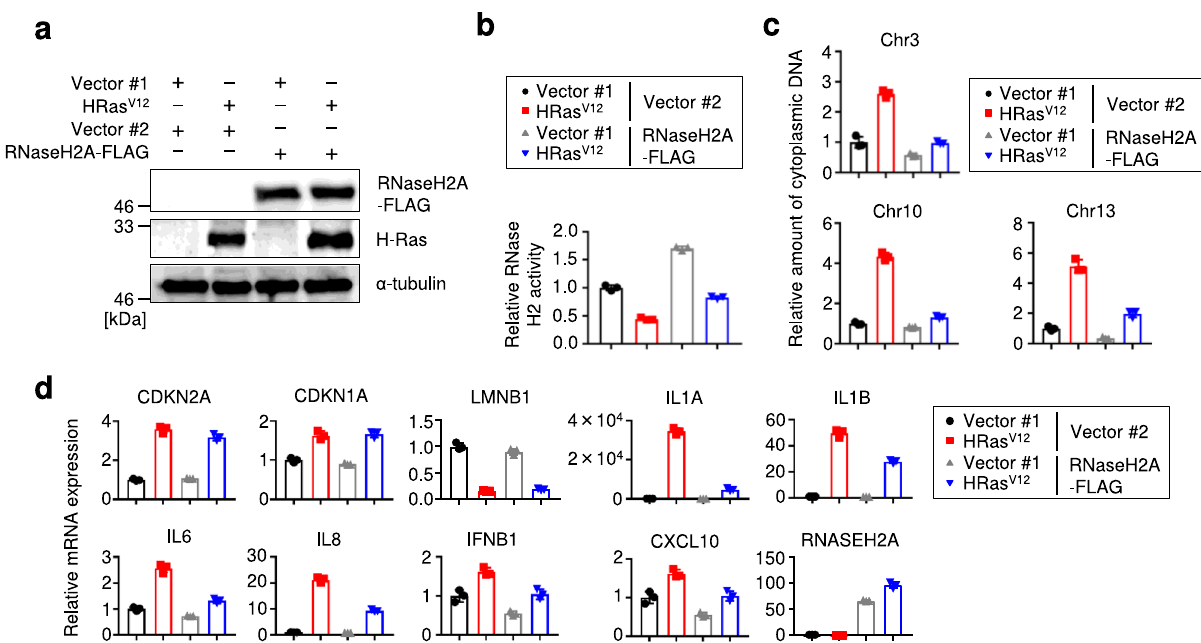
Fig. 5 RNaseH2A suppresses the expression of SASP factor genes. a Western blot of TIG-3 cells infected with retrovirus encoding fl ag-tagged RNaseH2A (lanes 3 and 4) or empty vector (lanes 1 and 2). After puromycin selection, cells were infected with retrovirus encoding HRas V12 and subjected to western blot analysis using the antibodies shown at right. Alpha-tubulin was used as a loading control. b In vitro RNase H2-speci fi c activity assay of TIG- 3 cells as in a . Error bars indicate the mean ± SD of technical triplicates. c Quantitative PCR analysis of chromosomal DNA in the cytoplasm from TIG-3 cells as in a using primers against chromosomes 3, 10 and 13. Error bars indicate the mean ± SD of technical triplicates. d RT-qPCR analysis of the indicated genes was conducted using RNA extracted from TIG-3 cells as in a . Error bars indicate the mean ± SD of technical triplicates. All data were representative of at least three biological